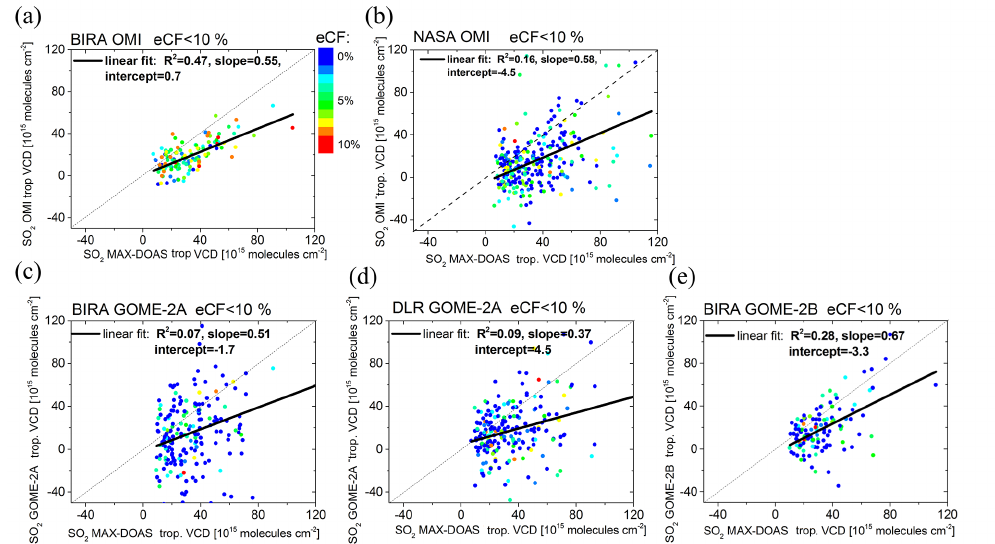
Figure 4. Daily-averaged OMI SO 2 tropospheric VCDs from BIRA (a) and NASA (b) , GOME -2A SO 2 tropospheric VCDs from BIRA (c) and DLR (d) , and GOME-2B SO 2 tropospheric VCDs from BIRA (e) for eCF<10% plotted versus the coincident MAX-DOAS results. The colours indicate the eCF.